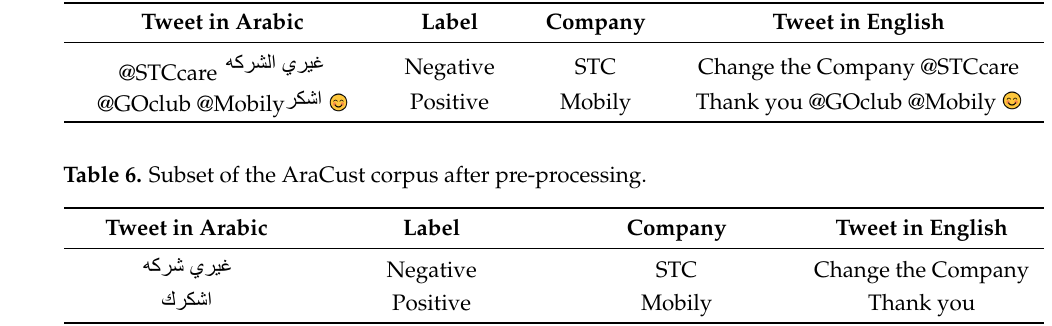
Table 7. Customer satisfaction rate vs. actual customer satisfaction.